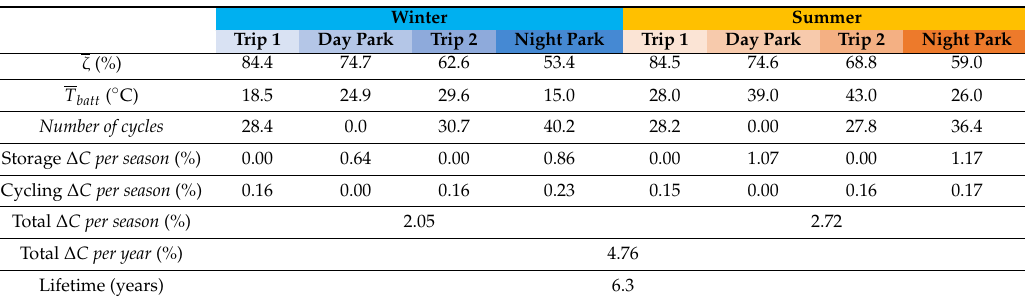
Table 4. Battery capacity loss and lifetime calculations.